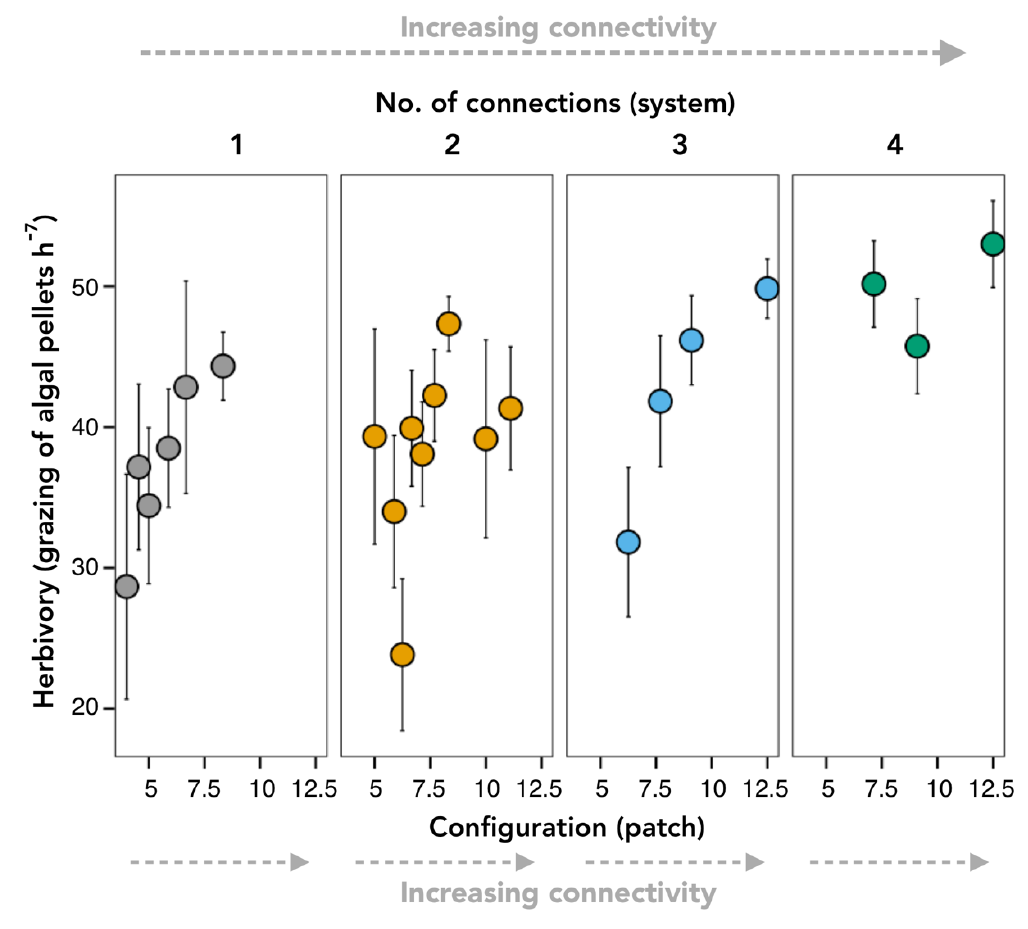
Figure 3. Herbivory during a press disturbance and the interaction between patch- and system-scale responses to an increase in connectivity. Herbivory is the mean (SE) number of algal pellets consumed after a 7 h period of a consistent supply of algae to disturbed patches in each system (colours indicate no. of connections at the system scale). No. of connections (system) is the number of connections linking the undisturbed to the disturbed part of the system. Configuration (patch) is a modified value for closeness centrality at the patch scale, which quantifies a commonly used dimension of connectivity.